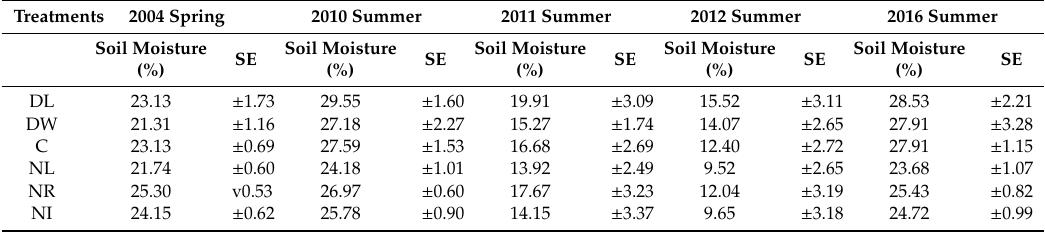
Table 2. Moisture content (%) of S í kf˝ok ú t soils in the studied periods.